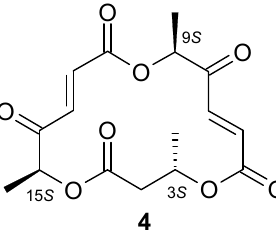
Figure 1. Results of the preparative biotransformation of bromo- and iodolactones 1 and 2 (in %) according to